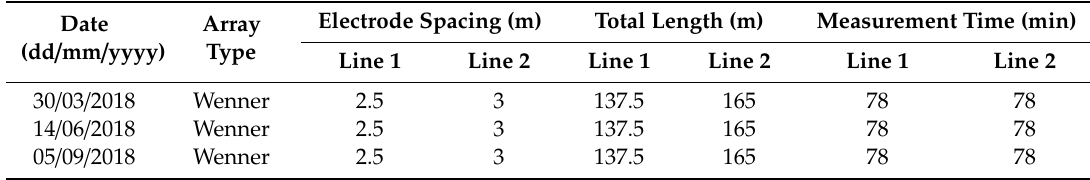
Figure 3. A schematic diagram of the Wenner array electrode configuration. ‘A’ and ‘B’ = current electrodes (I = current), ‘M’ and ‘N’ = potential electrodes (V = potential difference) and ‘a’ = spacing between electrodes. Table 1. Electrical resistivity survey plan. Table 1. Electrical resistivity survey plan.